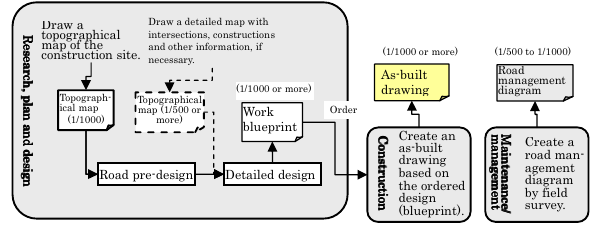
Figure 3. Flow of road